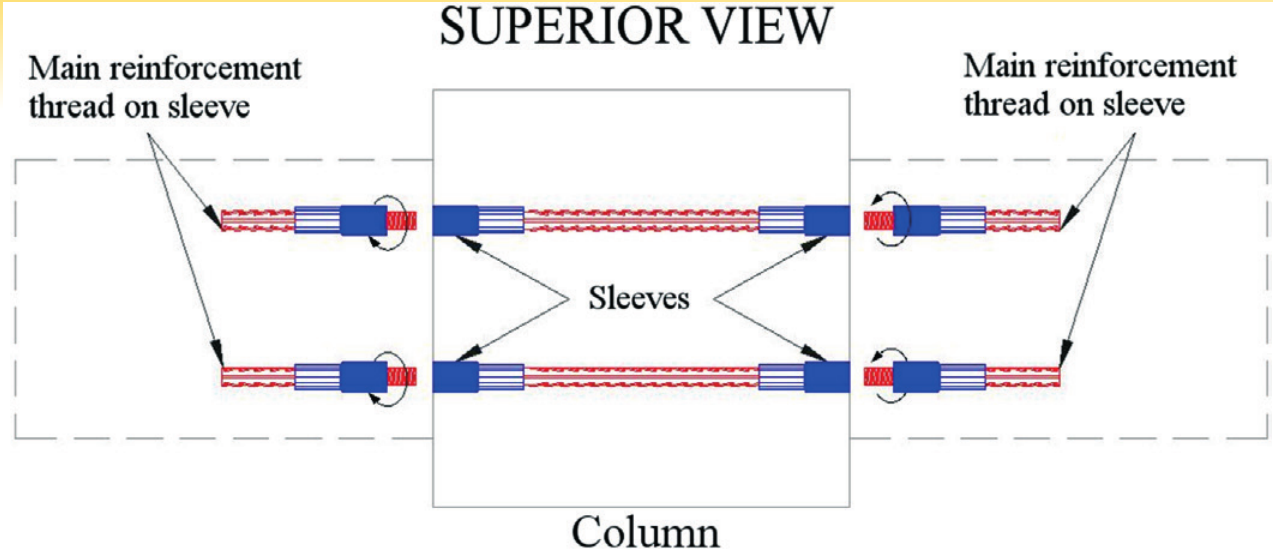
Scheme of splice with sleeves and threads for model P2 with corbels cast in different stages of the column